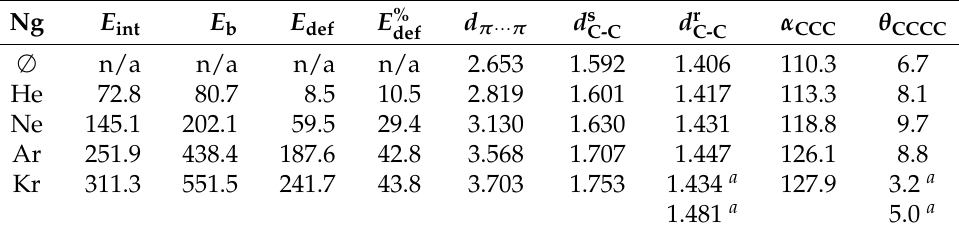
Table 2. Interaction, binding, and deformation energies (in kcal/mol) and selected geometric param- eters (in Å or degrees) for superphane ( ∅ ) and the Ng@superphane (Ng = He, Ne, Ar, Kr) complexes.